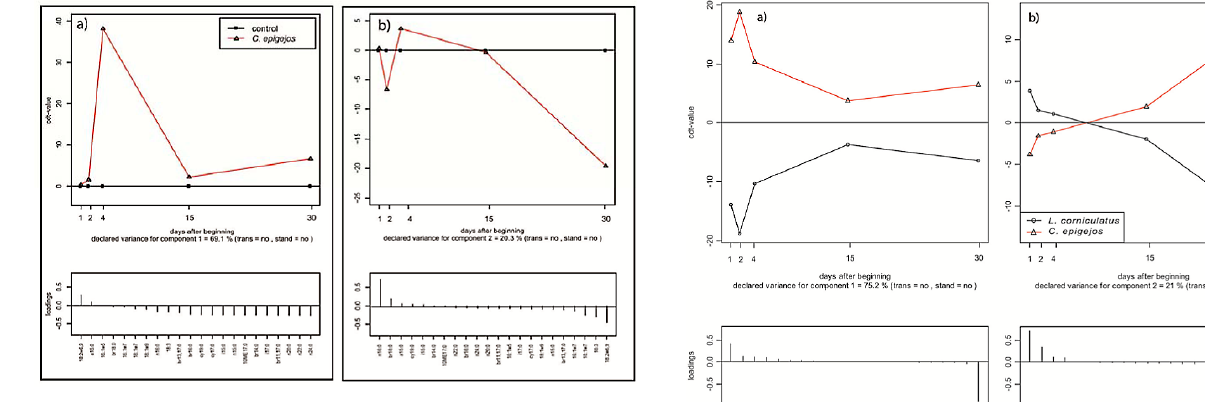
Fig. 4. First (a) and second (b) component of the PRC calculation on the basis of the mol% data of all individual PLFA relative to total PLFA of C. epigejos treatments compared to the control treatment throughout the experimental period of 30weeks ( n = 5).